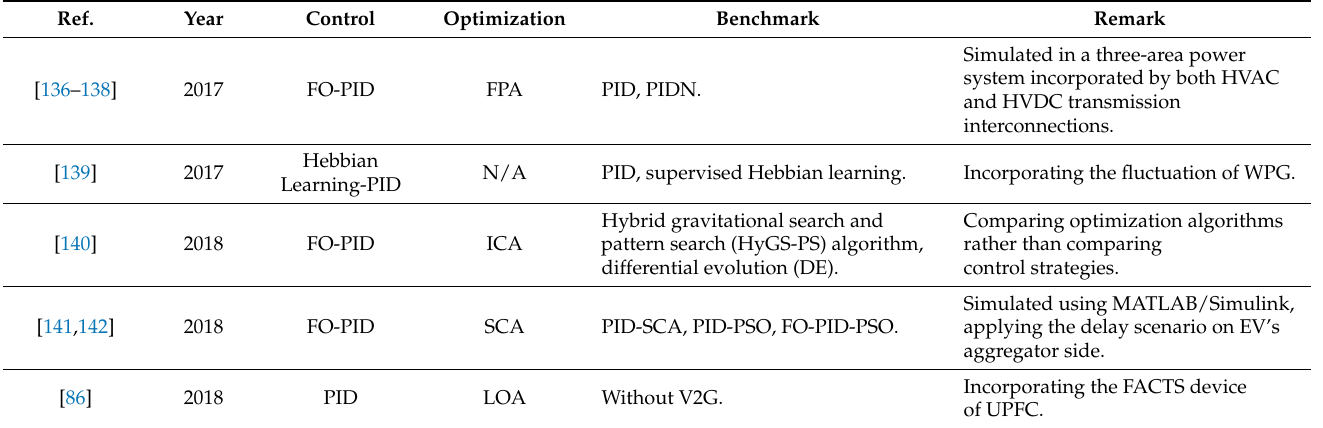
Figure 5. Chronological development of PID control variants as EVAS frequency contingency services. Table 2. EVAS as frequency contingency services with the PID